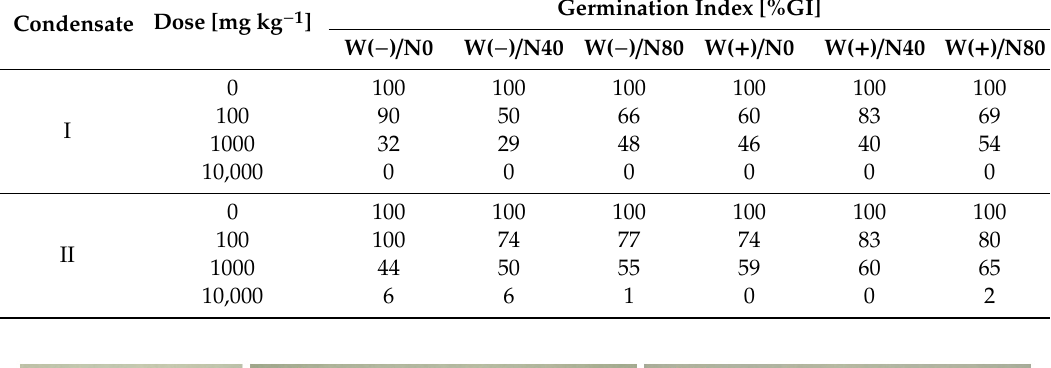
Table 1. Germination index in particular test objects depending on condensate type and dose. Condensate Dose [mg kg − 1 ]